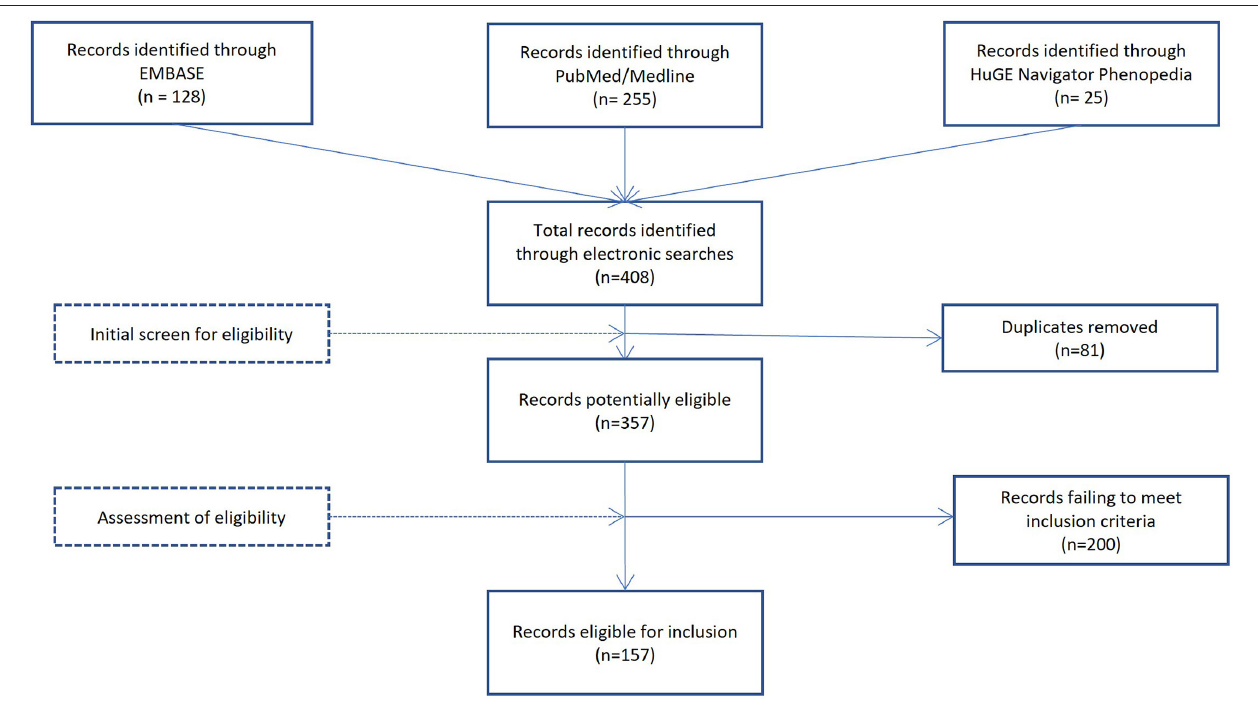
FIGURE 1 | Identification and selection process. The figure shows the sources used for identification and assessment of eligibility of studies for inclusion in this review with number of studies in